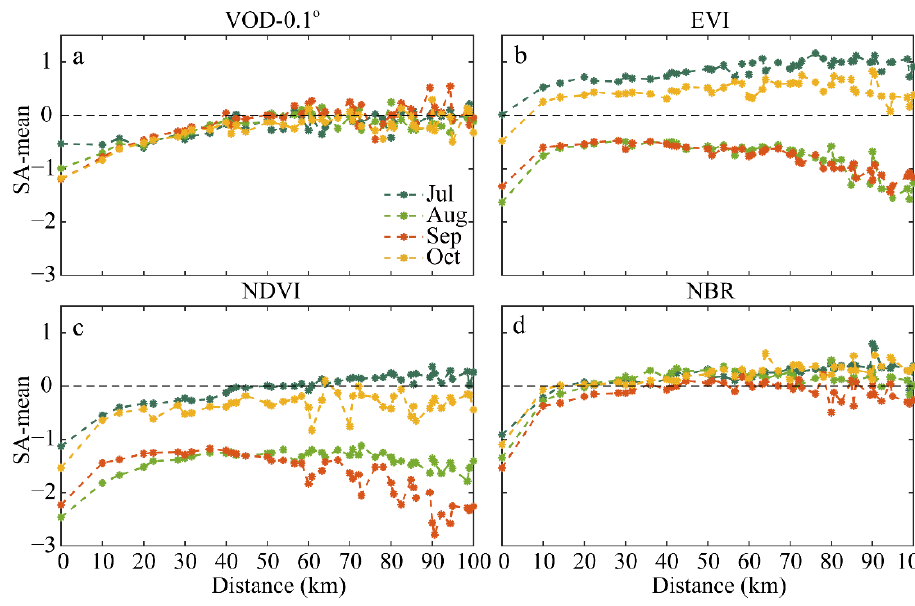
Figure 4. The mean of standard anomalies (SA-mean) of ( a ) VOD-0.1°; ( b ) EVI; ( c ) NDVI; and ( d ) NBR in unburned pixels at different distances from burned pixels.